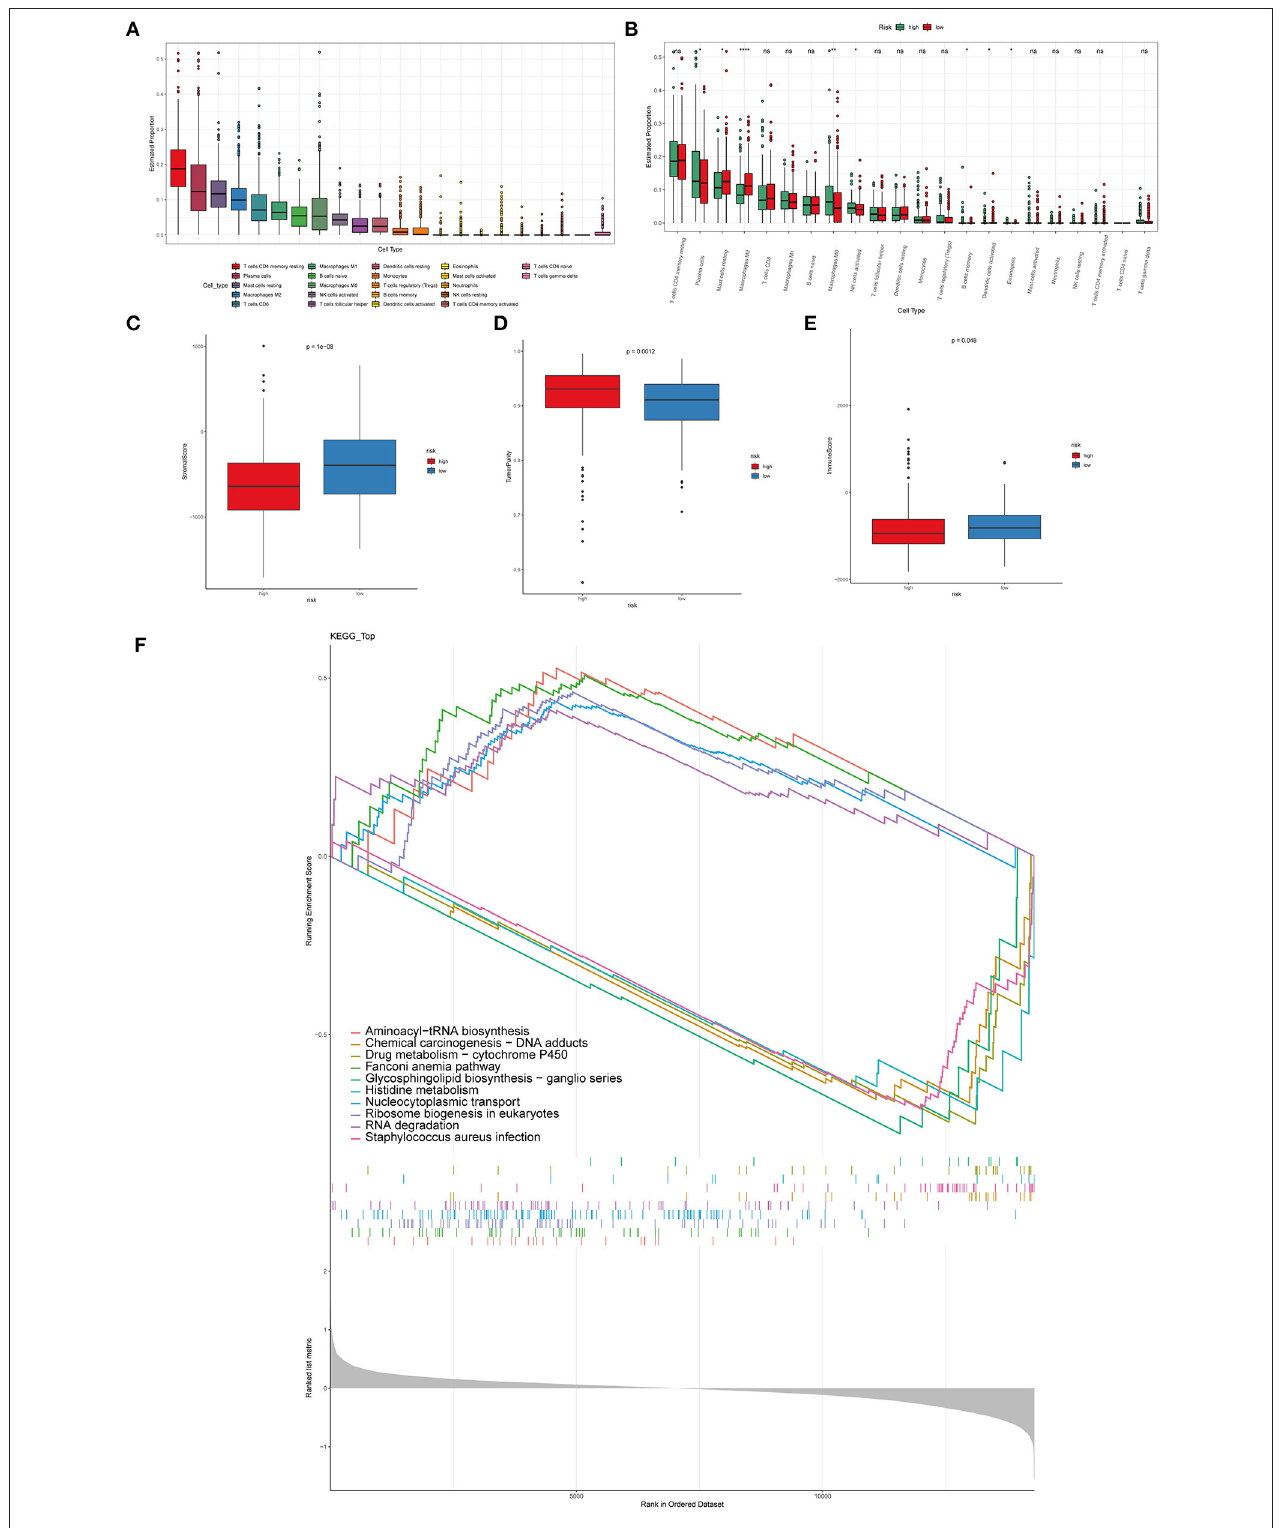
FIGURE 5 | Immune cell infiltration in PCa tissues of high- and low-risk patients. (A) The distribution of 22 types of immune cells between primary and metastatic PCa tissues. (B) Comparisons between immune cells in the high- and low-risk groups in TCGA. * p < 0.05, ** p < 0.01, **** p < 0.0001. The stromal score (C) , tumor purity (D) , immune score (E) in the high- and low-risk groups. (F) The GSEA analysis was performed to characterize important functional phenotypes and different gene sets between the high-risk and low-risk score groups.